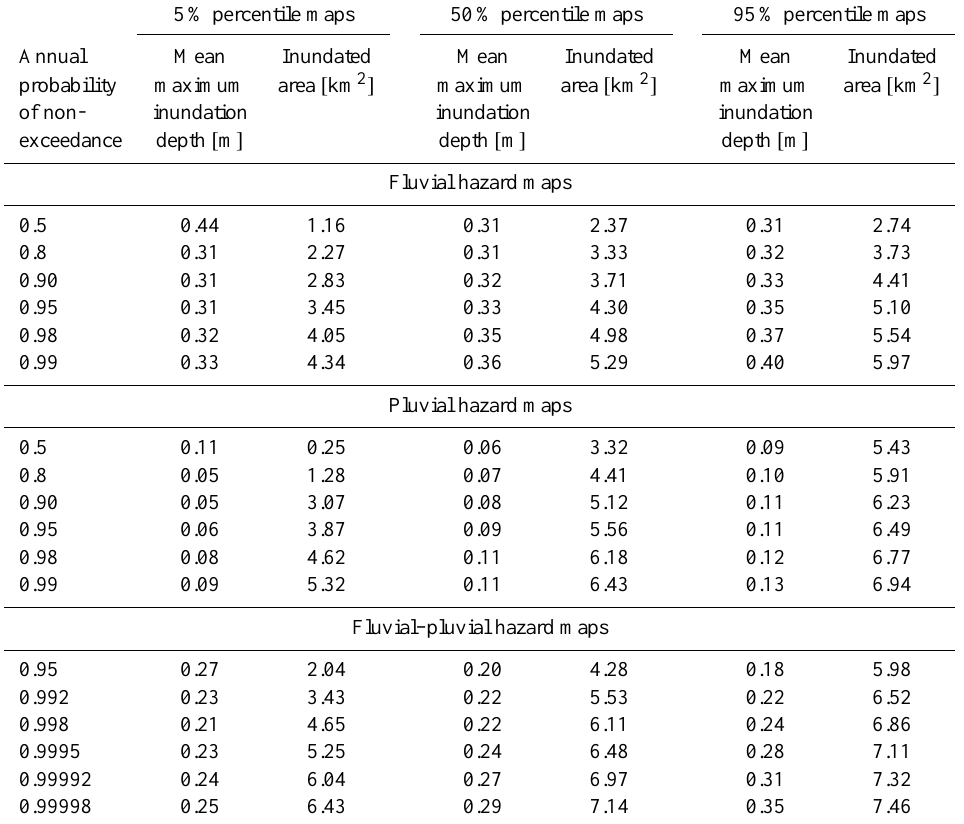
Table 2. Statistical evaluation of probabilistic hazard maps: mean maximum inundation depths and inundated area for every hazard map (annual probabilities of non-exceedance and percentile maps). For the statistics the channel and the river boundary cells were excluded, as well as cells with maximum inundation depths <